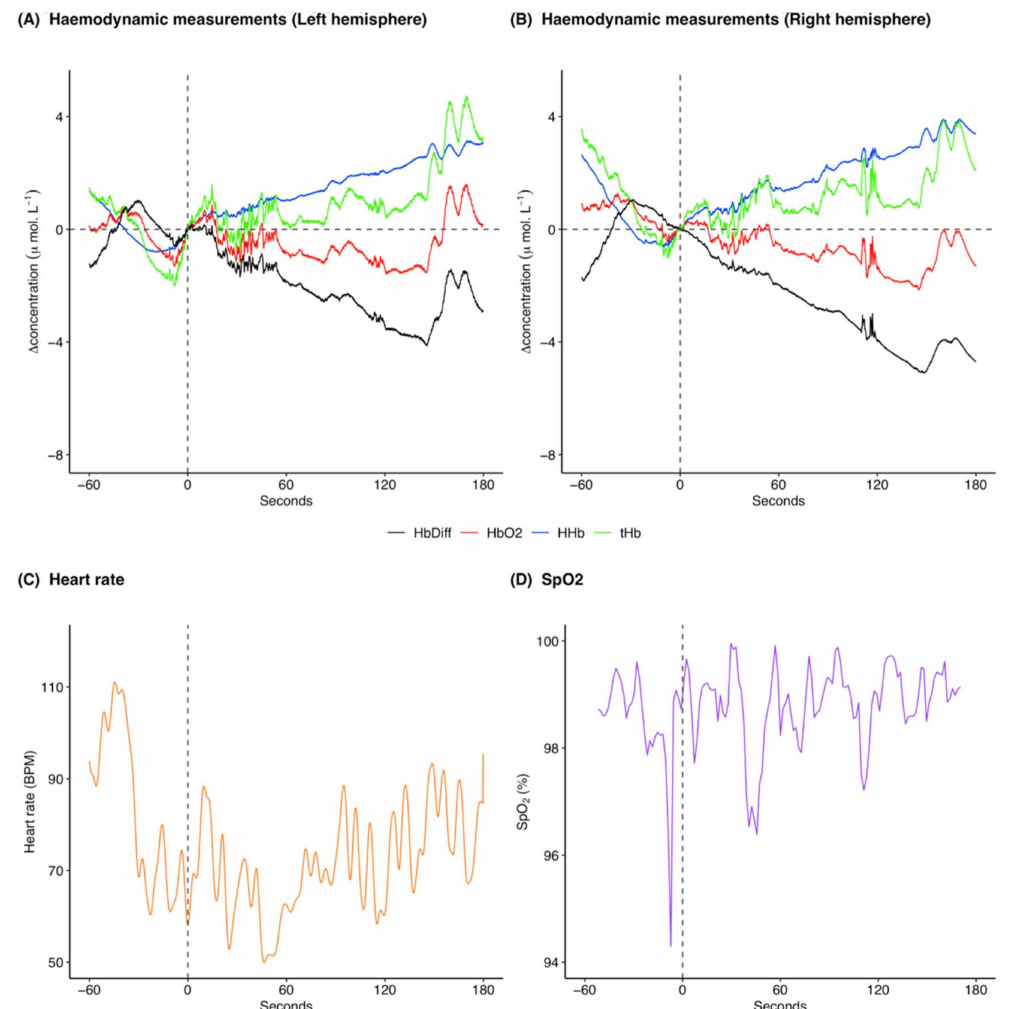
Figure 5. Example of cerebral haemodynamics and global systemic changes for 60 s before and 180 s after midazolam administration at time 0 s for one drugging trial. Cerebral haemodynam- ics include [ ∆ HHb] ( µ mol L − 1 ), [ ∆ O 2 Hb] ( µ mol L − 1 ), relative cerebral blood volume changes [ ∆ tHb] ( µ mol L − 1 ), and relative haemoglobin oxygenation changes [ ∆ Hb diff ] ( µ mol L − 1 ) in the ( A ) left and ( B ) right hemispheres of the brain. Systemic changes include ( C ) heart rate (BPM) and ( D ) SpO 2 (%). All concentrations are expressed as relative changes from a baseline (0 µ mol L − 1 ) at time of drug administration. This midazolam drugging trial was taken from Gruber on dose of midazolam, and three intravenous ketamine doses. For combined raw data for all mida- zolam drugging trials see Supplementary Figures S5 and S6. [ ∆ HHb], change in concentration of deoxygenated haemoglobin; [ ∆ O 2 Hb], change in concentration of oxygenated haemoglobin; [ ∆ tHb], change in concentration of total haemoglobin; [ ∆ Hb diff ], difference in concentration of oxygenated and deoxygenated haemoglobin; SpO 2 , arterial oxygen